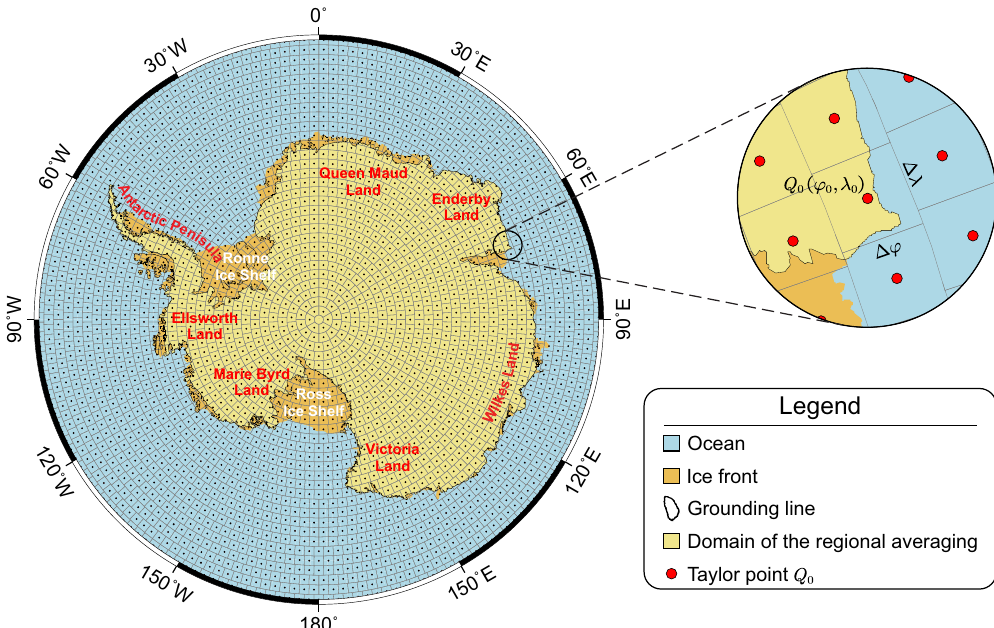
Figure 2. The map shows the division of the Antarctica Ice Sheet (AIS) into the ice front (defines the coastlines) and grounding line (defines the landmasses) with the limits established by Rignot et al. [53]. The AIS base map also shows the partitioning of the sphere into equal-area spherical panels used in GSFC-M as defined by Luthcke et al. [24], in which the respective geometrical centers (red circles) depict the Taylor points Q 0 . The insert illustrates the geometry of an individual equal-area spherical panel in view of the equations presented in Sections 2.1.1 and